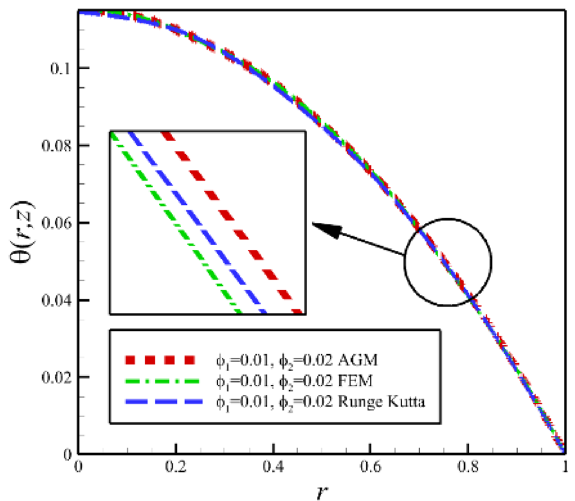
Fig. 8 The result of temperature based on AGM, FEM, and Runge– Kutta with 𝜙 2 =0.05